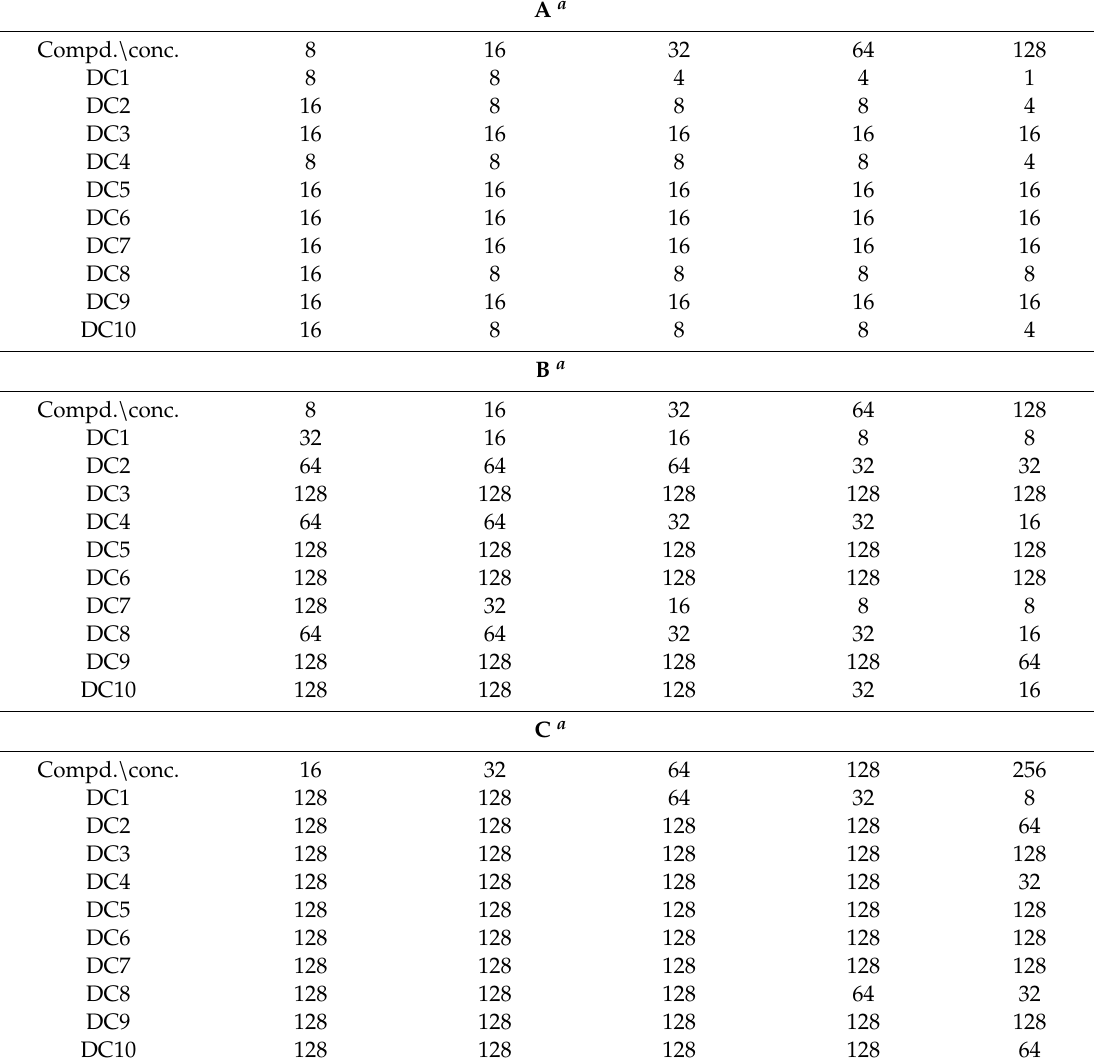
Table 2. Antibacterial activities (MICs, µ g / mL) of imipenem on E. coli BL21 expressing ImiS ( A ), cefazolin against E. coli BL21 expressing NDM-1 ( B ) and L1 ( C ) in the presence of dithiocarbamates at a concentration ranging from 8 to 128 µ g / mL and 16 to 256 µ g /